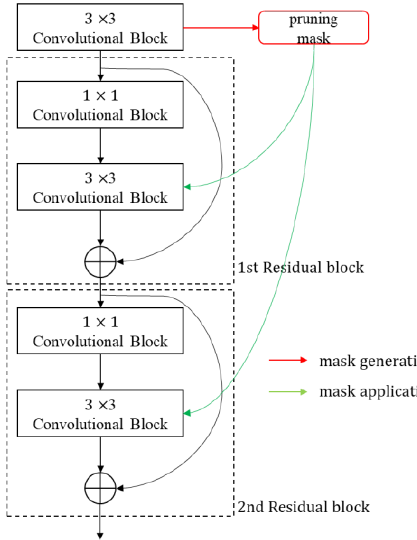
Figure 6. Head-first method.